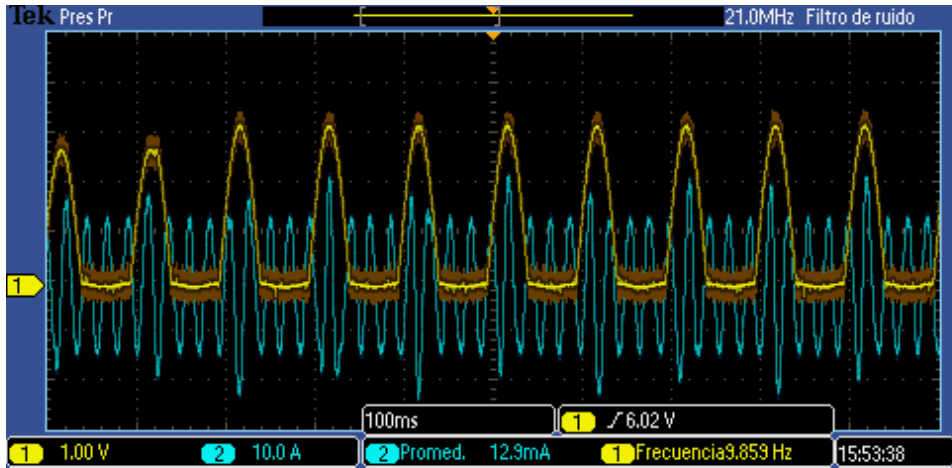
Figure 25. Motor current behavior after a step in the peak current reference from 18 A to 21 A. Pedaling frequency, 10 Hz.